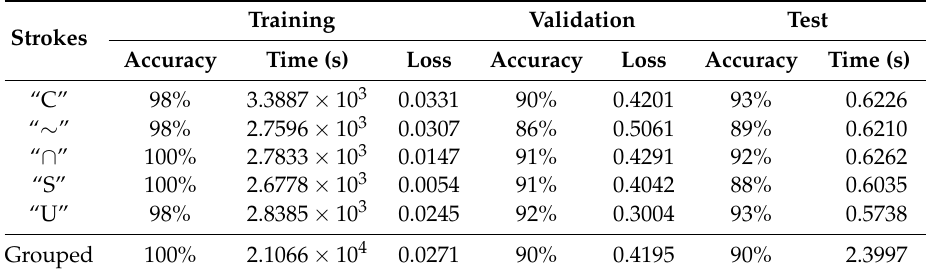
Table 4. Rectified Simple Grapheme-AlexNet (epoch =